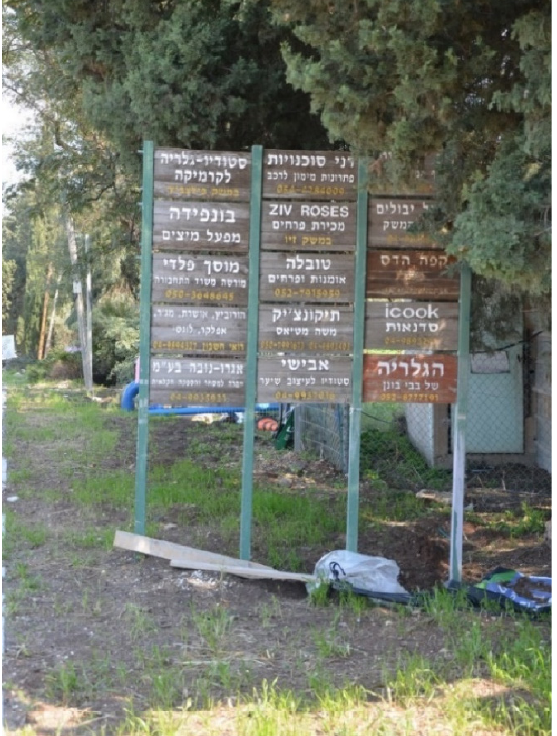
Figure 4. Non-agricultural businesses at Moshav HaYogev, including baking workshops, accountants, and a ceramic studio. The businesses are located on the family plots. Photo by the authors.